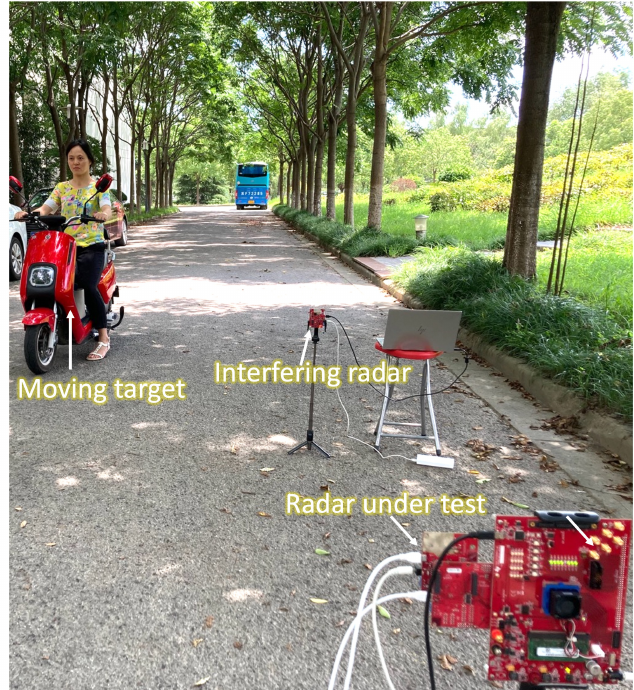
Figure 9. Real radar field experiments.